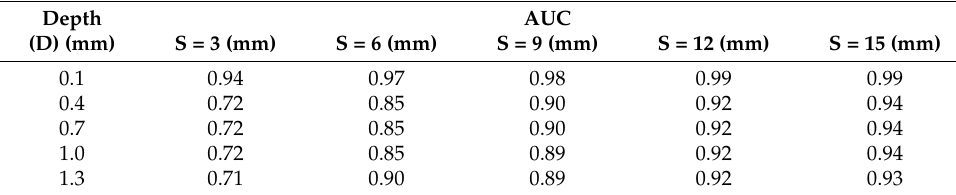
Table 5. AUC indicator for maxigrams of simulated thermal sequences.